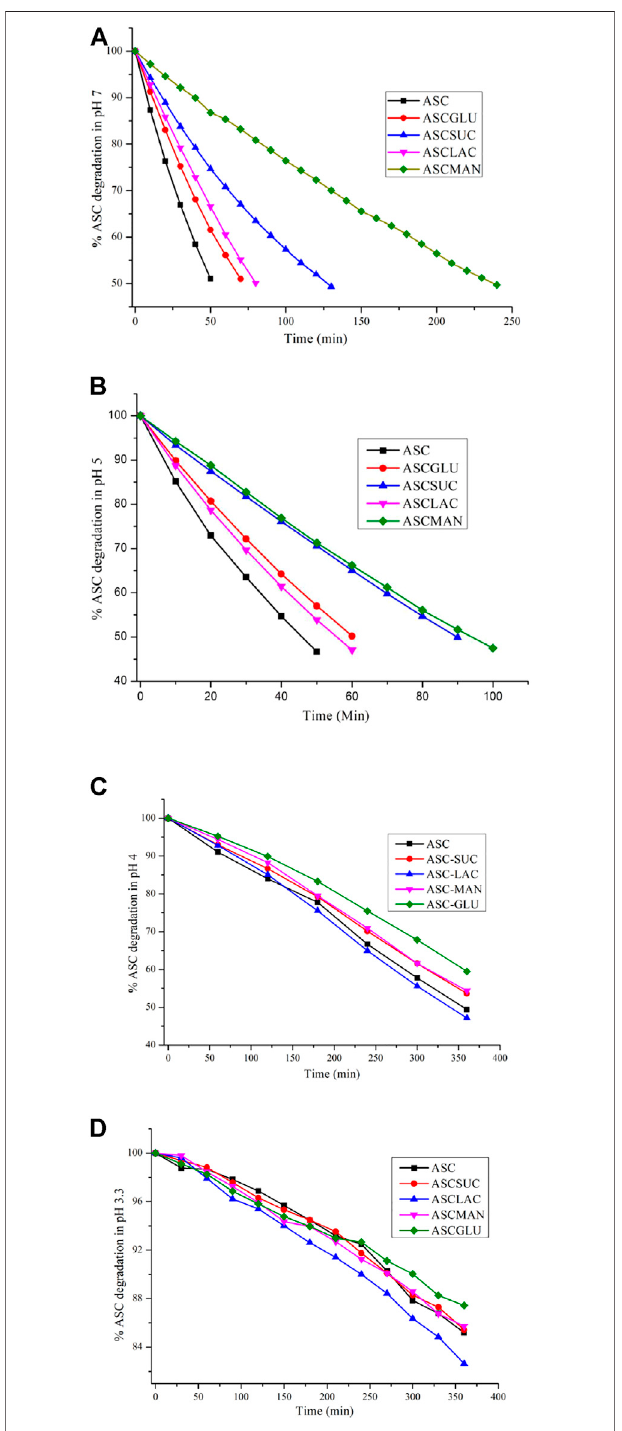
FIGURE 4 | ASC degradation of the sugar eutectics in (A) pH 7, (B) pH 5, (C) pH 4, and (D) pH 3.3 acetate buffer medium. Note, UV measurements were recorded at 30 min intervals in pH 4 and 3.3 acetate